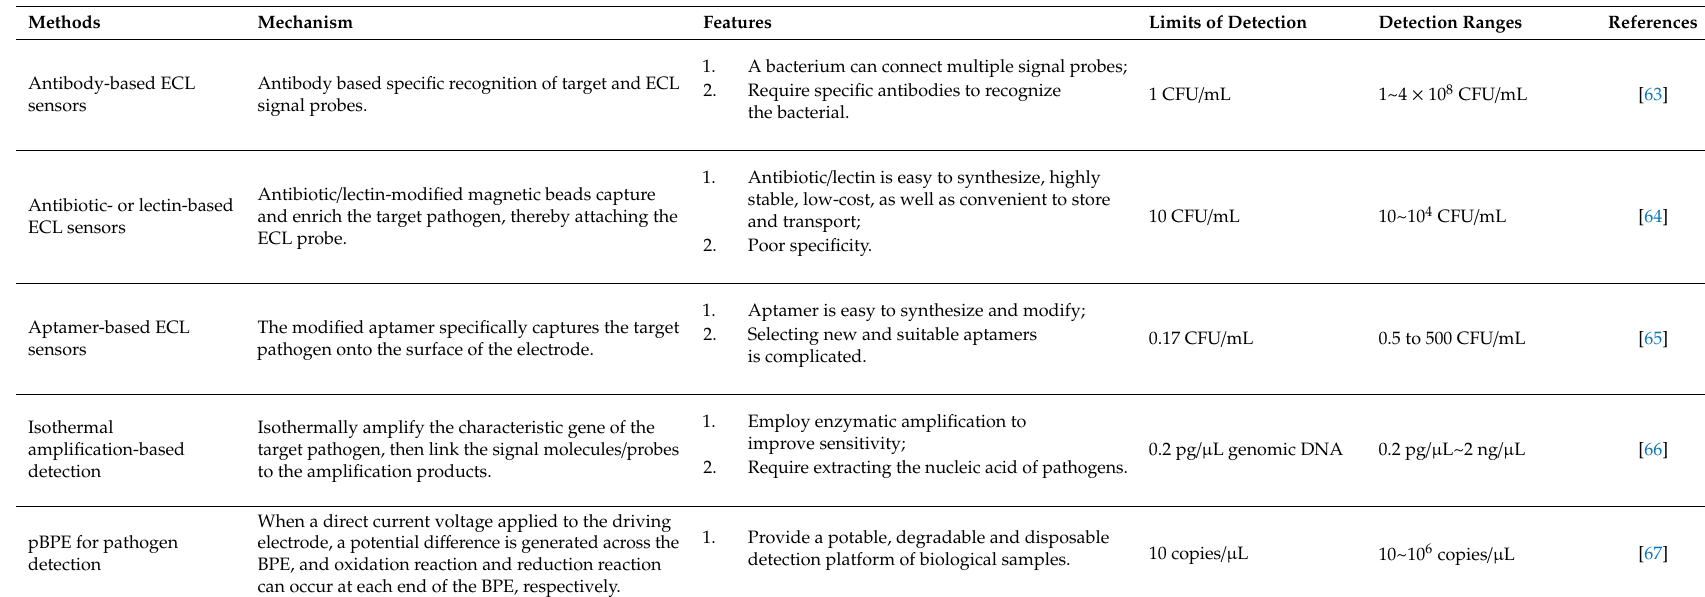
Table 1. Existing ECL methods for pathogens